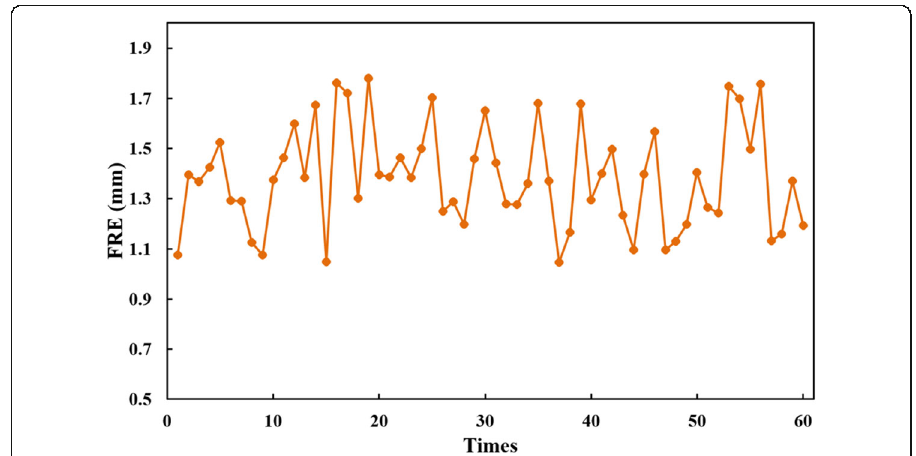
Fig. 8 FRE values obtained from all the calibrations